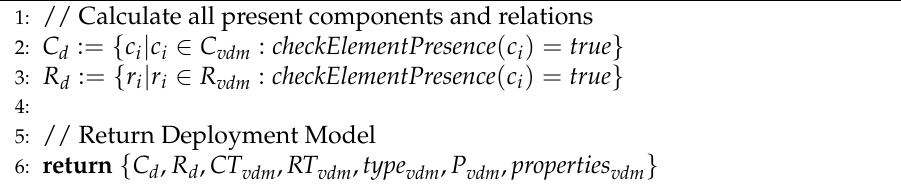
Algorithm 1 resolveVariability( vdm ∈ VDM ): d ∈ D vdm